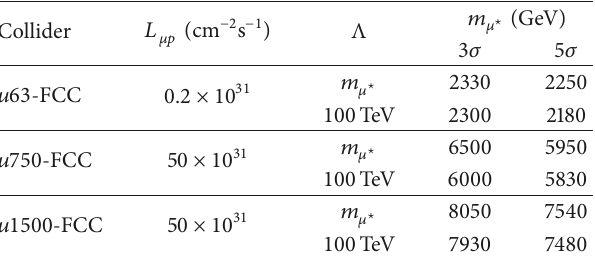
Table 3: Mass limits for 𝜇 ⋆ at FCC-based 𝜇𝑝 colliders.